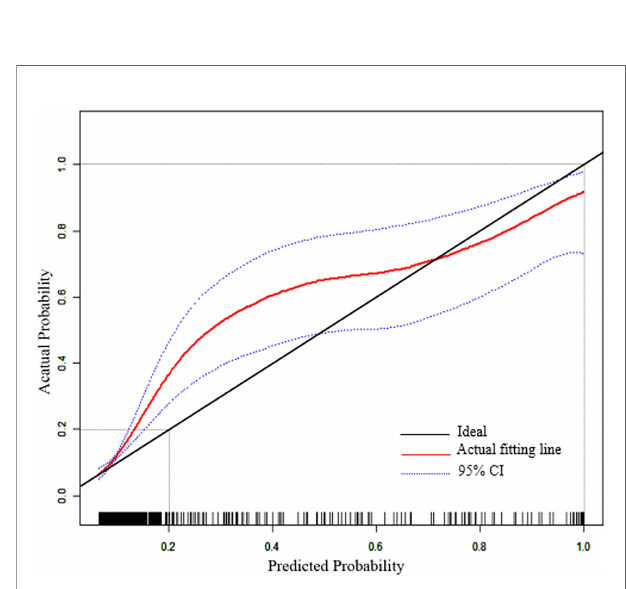
FIGURE 4 | Calibration plot of the nomogram model. The solid line (black) is the reference line and indicates that the predicted value is equal to the actual value. The dashed line (red) represents the actual nomogram curve fi tting line, whereas the dashed line (blue) represents the 95%